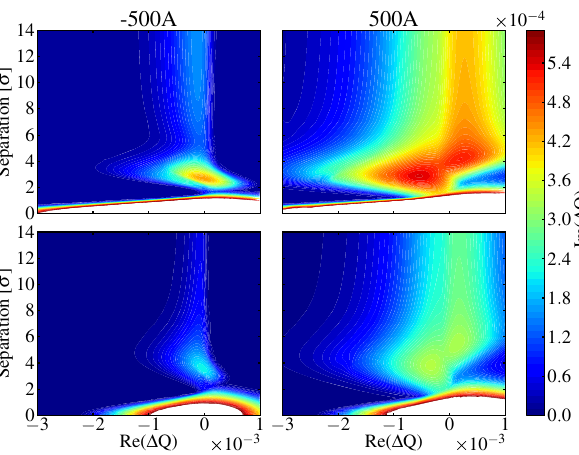
FIG. 10. Stability diagram as a function of beam separation in IP1 and 5 for both polarities of the octupoles. The upper and bottom plots corresponds to, respectively, 2012 and nominal